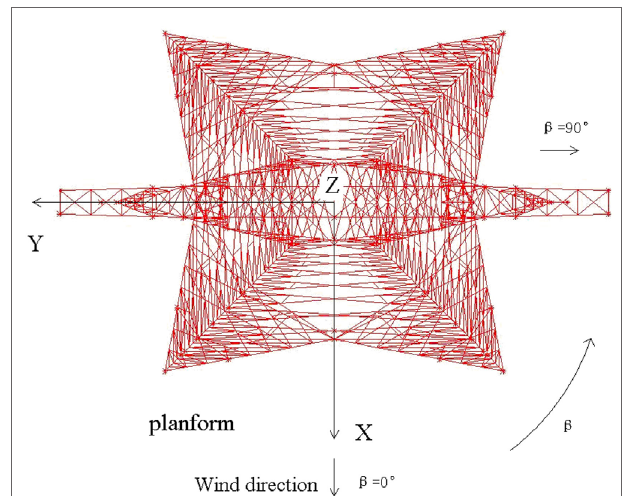
FigUre 5 | aeroelastic model in wind tunnel .